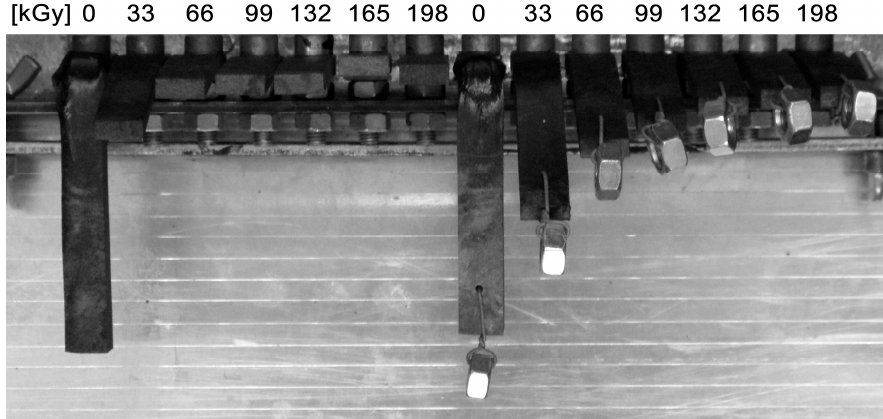
Figure 23. V isual observation after 1 h at 300 °C—High-performance polymers (PA9T). Figure 23. Visual observation after 1 h at 300 ◦ C—High-performance polymers